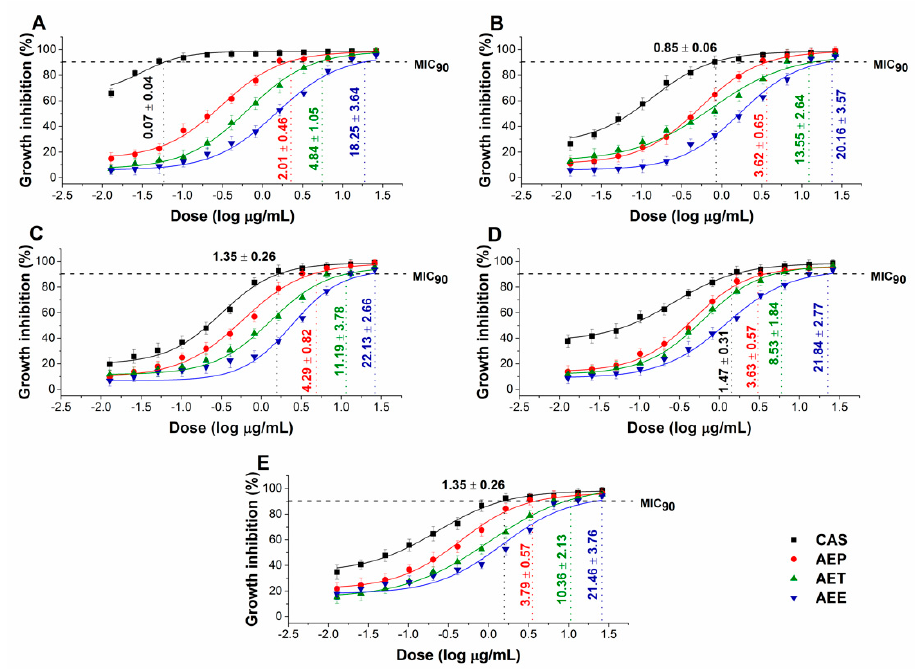
Figure 4. Minimum inhibitory concentration (MIC 90 ) of AEP, AET, AEE, and caspofungin (CAS) in µg/mL on S. pombe ( A ), C. albicans ( B ), C. tropicalis ( C ), C. dubliniensis ( D ) and C. krusei ( E ). Six independent experiments each with three technical replicates were performed (mean ± SD).